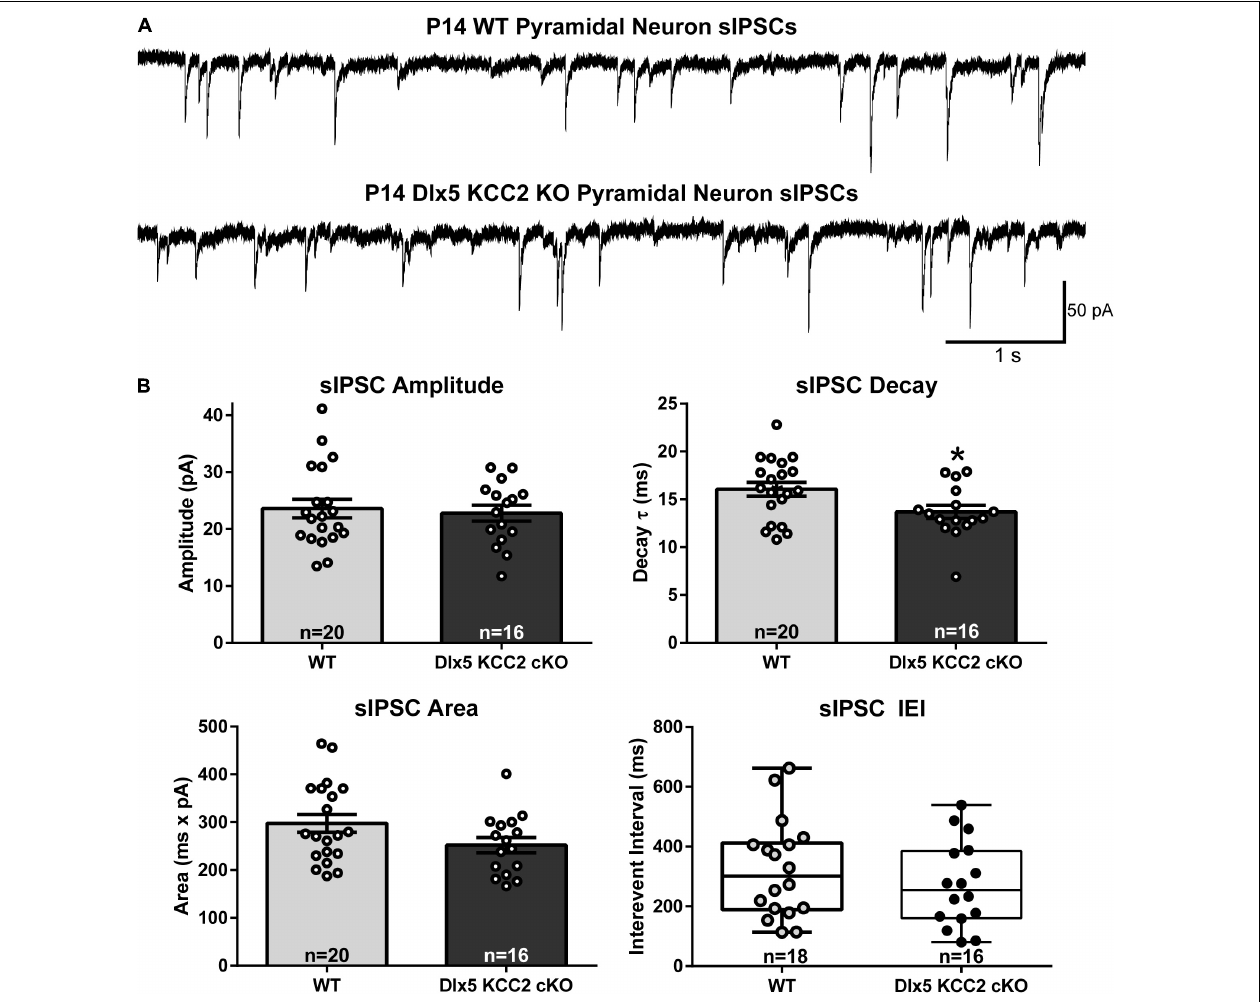
FIGURE 6 | Normal sIPSC frequency, faster decay in pyramidal neurons in KO. (A) Sample recordings of spontaneous IPSCs in layer 5 pyramidal neurons in barrel cortex of P12–14 WT and Dlx5 KCC2 cKO. (B) Amplitude, area, decay (mean ± SEM), and inter-event interval (IEI, box and whisker plot showing median, 25/75 percentile, and maximum/minimum) of spontaneous IPSCs in layer 5 pyramidal neurons in barrel cortex of P12–14 WT and Dlx5 KCC2 cKO. T -test: * P < 0.05. Non-parametric Mann–Whitney test was used for IEI only. n values at the bottom of each bar/box and whisker plot indicate the number of cells recorded, taken from ≥ 5 mice, for each